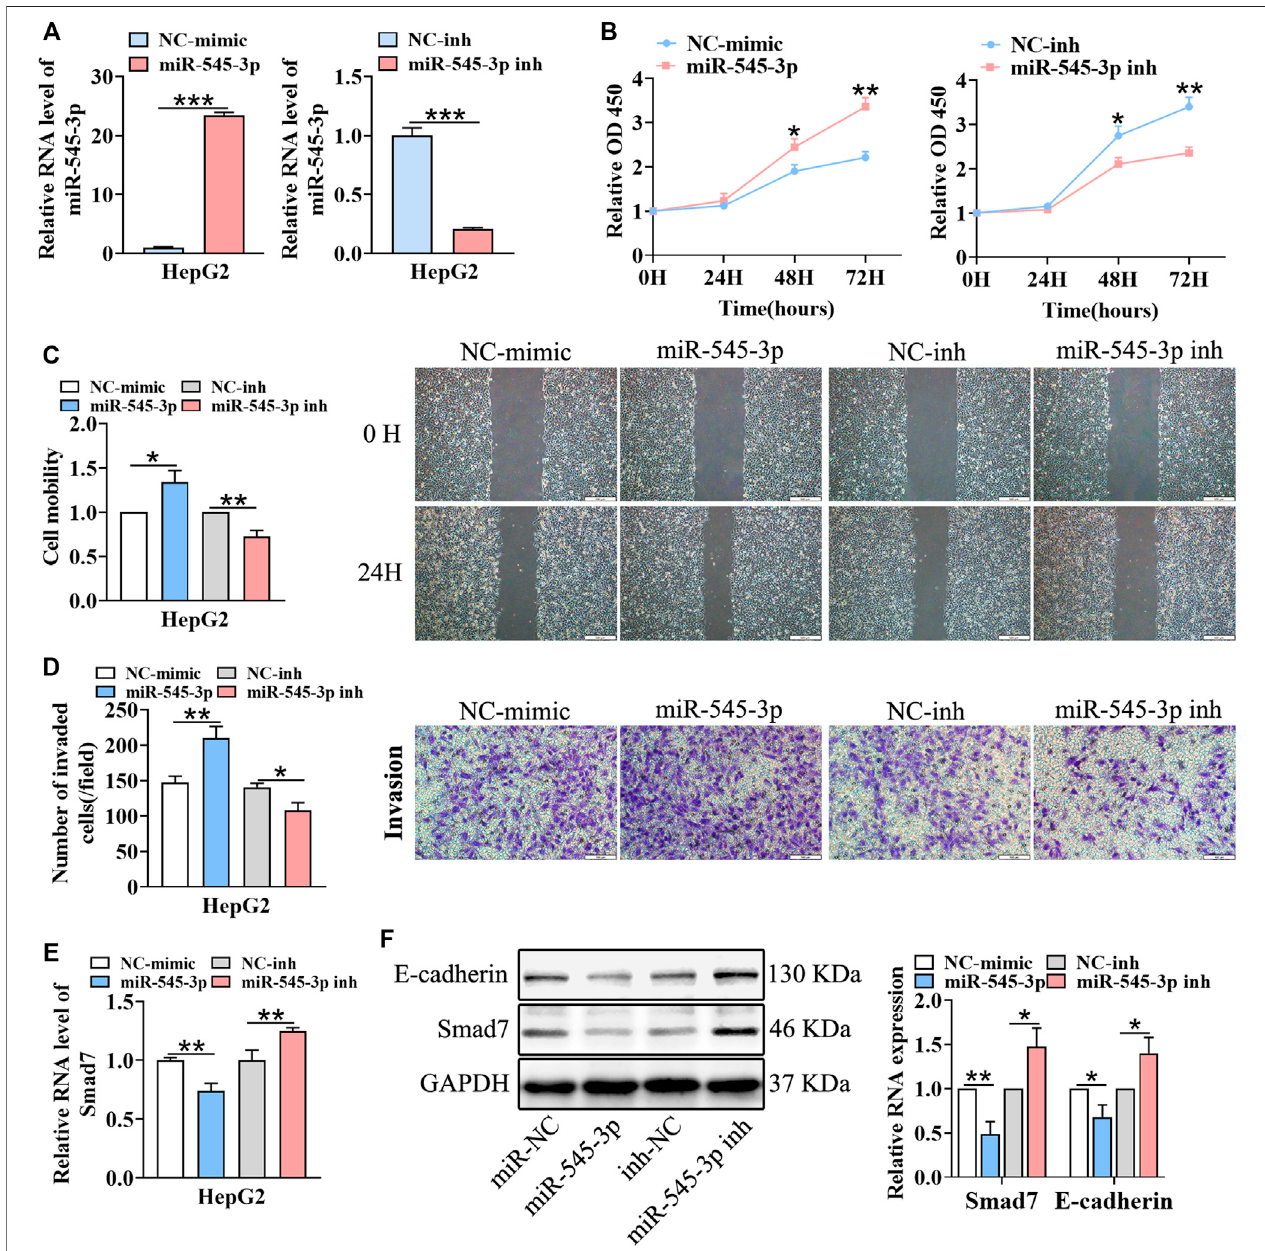
FIGURE5| miR-545-3p promotescellgrowth, migration,invasion,EMTanddownregulatestheexpressionofSmad7 invitro . (A) qRT-PCRvalidatedmiR-545-3p upregulation in HepG2 cells transfected with miR-545-3p mimics and downregulation in HepG2 cells transfected with miR-545-3p inhibitors. B-D. CCk8 assays (B) , scratch wound healing assay (C) and transwell invasion assay (D) assessed the cell proliferation, migration and invasion potential in HepG2 cells transfected with miR- 545-3pmimicsorinhibitors.Scalebar,500 µm (C) ,100 µm (D) . (E) qRT-PCRdetectedtheRNAexpressionofSmad7inHepG2cellstransfectedwithmiR-545-3p mimics or inhibitors. (F) Western blot detected the expression of Smad7 and E-cadherin in HepG2 cells transfected with miR-545-3p mimics or inhibitors. Data were shown as mean ± SD, ( n = 3). * p < 0.05, ** p < 0.01, *** p < 0.001 in independent Student ’ s t test (A,C – F) and in two-way ANOVA (B) .